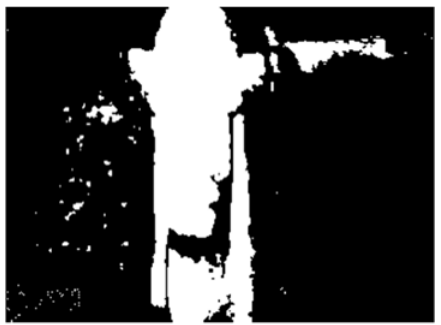
The next, the step was binarization of matrix K . Binarization threshold was equal to 0.5 (0.5 < K < 1). It is shown in Figure 15.